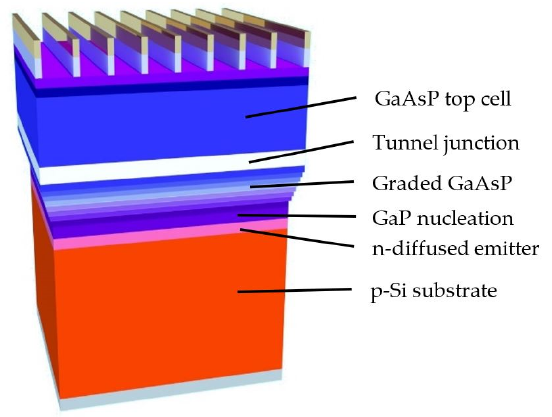
Figure 1. Structure of the tandem GaAsP/Si solar cell that is the target of this research. The widths of the figure represent schematically the lattice constant.